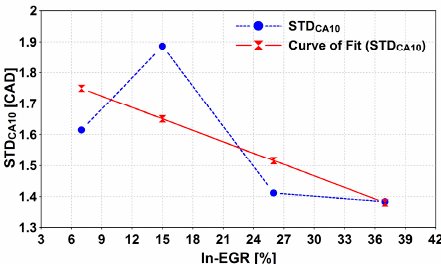
Figure 10. Cyclic variability of CA10 with In-EGR setting [rpm = 3000, IMEP = 2.1 bar, T epc = 425 – 530 K].